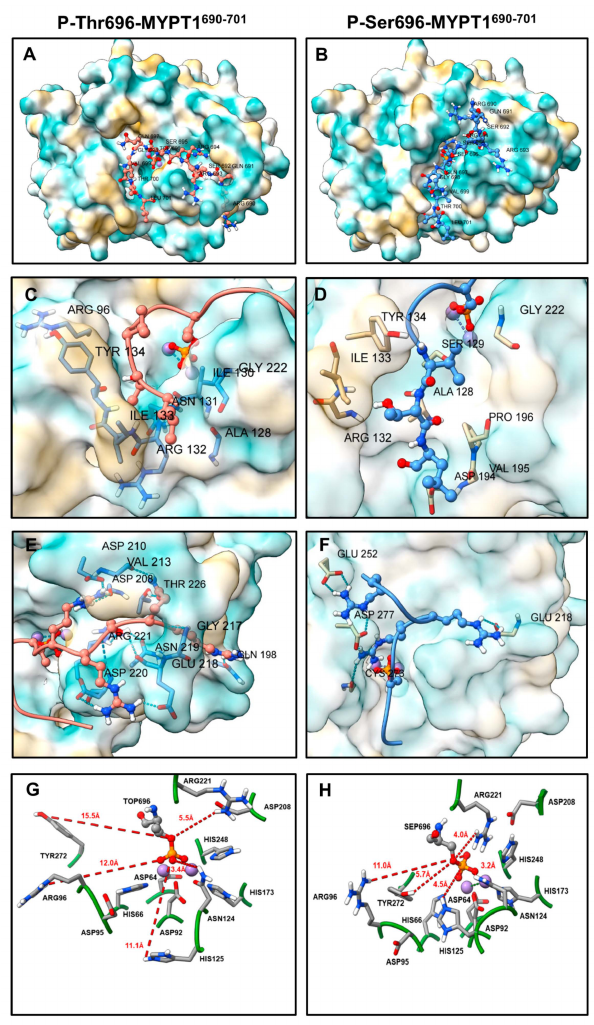
Figure 5. Poses of P-Thr696-MYPT1 690 − 701 and P-Ser696-MYPT1 690 − 701 peptide on the surface of PP1c derived from molecular docking simulations. Poses of P-Thr696-MYPT1 690 − 701 ( A ) and P- Ser696-MYPT1 690 − 701 ( B ) peptides on PP1c. Enlarged images of the binding of hydrophobic residues of P-Thr696-MYPT1 690 − 701 ( C ) and P-Ser696-MYPT1 690 − 701 ( D ) at the hydrophobic groove of PP1c. Enlarged images for the binding of basic residues of P-Thr696-MYPT1 690 − 701 ( E ) and P-Ser696- MYPT1 690 − 701 ( F ) to PP1c. Distances of the PP1c amino acid side chains from the coordinated phosphoryl residue of the substrate in the docked complexes of PP1c-P-Thr696-MYPT1 690 − 701 ( G ) and PP1c-P-Ser696-MYPT1 690 − 701 ( H